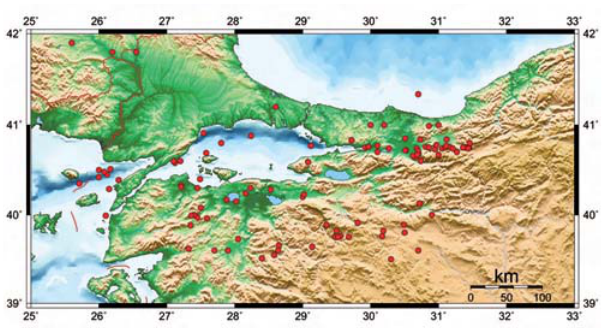
Figure 2. Seismicity of the Sea of Marmara region since 1900 for event magnitudes M>5 (Kandilli Observatory and Earthquake Research Institute, National Earthquake Monitoring Center (KOERI-NEMC), 2005).